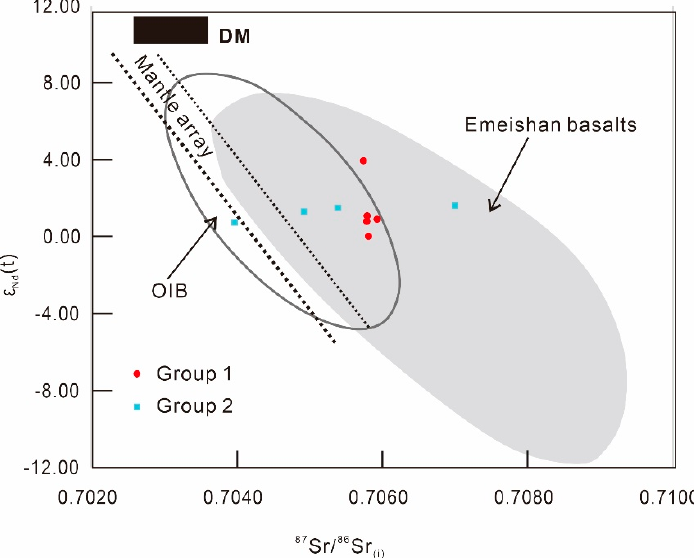
Figure 8. Sr − Nd isotopic compositions of the Dashibao basalts in the Xindianzi area. Emeishan basalts are according to [61], and DM (depleted mantle) is according to [58].